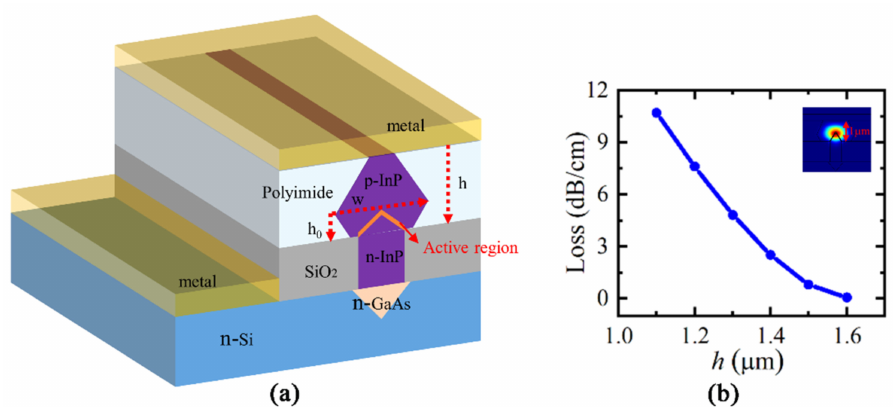
Figure 6. ( a ) Schematic illustrating the layout of the designed layer grown on pre-patterned Si substrate. ( b ) Calculated metal absorption loss of the fundamental TE mode inside the microwire with RRW as a function of the reserved height of the microwire ( h ). The insert shows the calculated profile of the fundamental TE mode supported inside the microwire, and h 2 is 1 µ